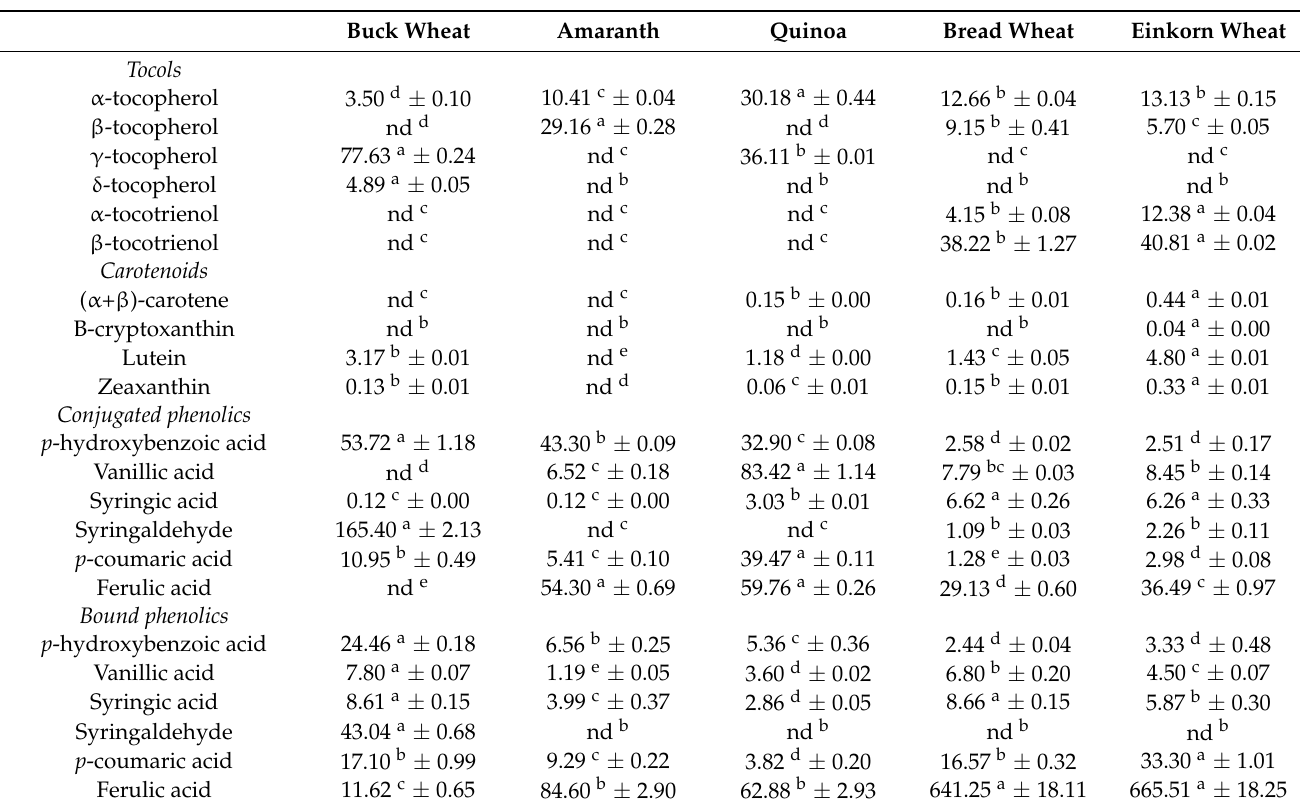
Table 1. Carotenoid, tocol and phenolic composition (mg/kg DM) of wholemeals of buckwheat, amaranth, quinoa, bread wheat and einkorn wheat. Buck Wheat Amaranth Quinoa Bread Wheat Einkorn